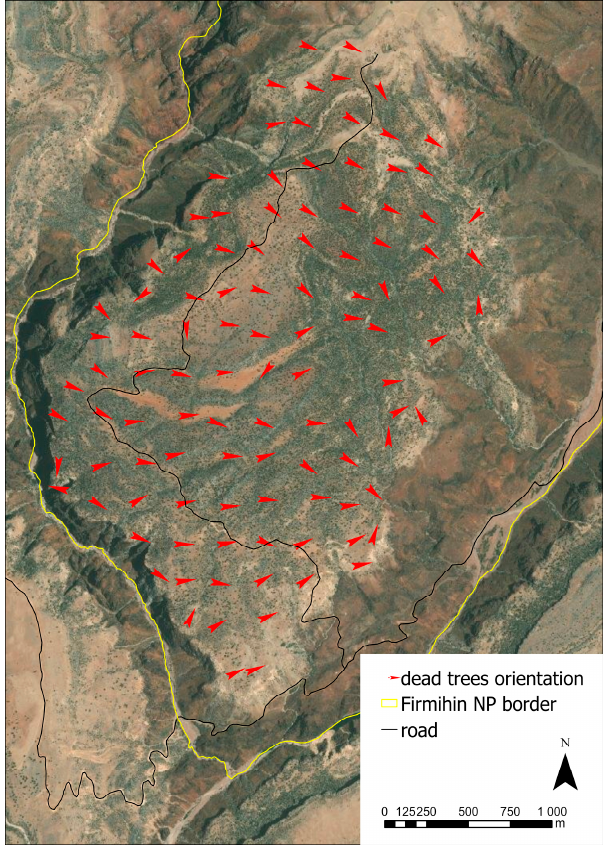
Figure 10. General orientation of uprooted Dracaena trees (directions from stem base to crown) in Firmihin, Socotra Island.